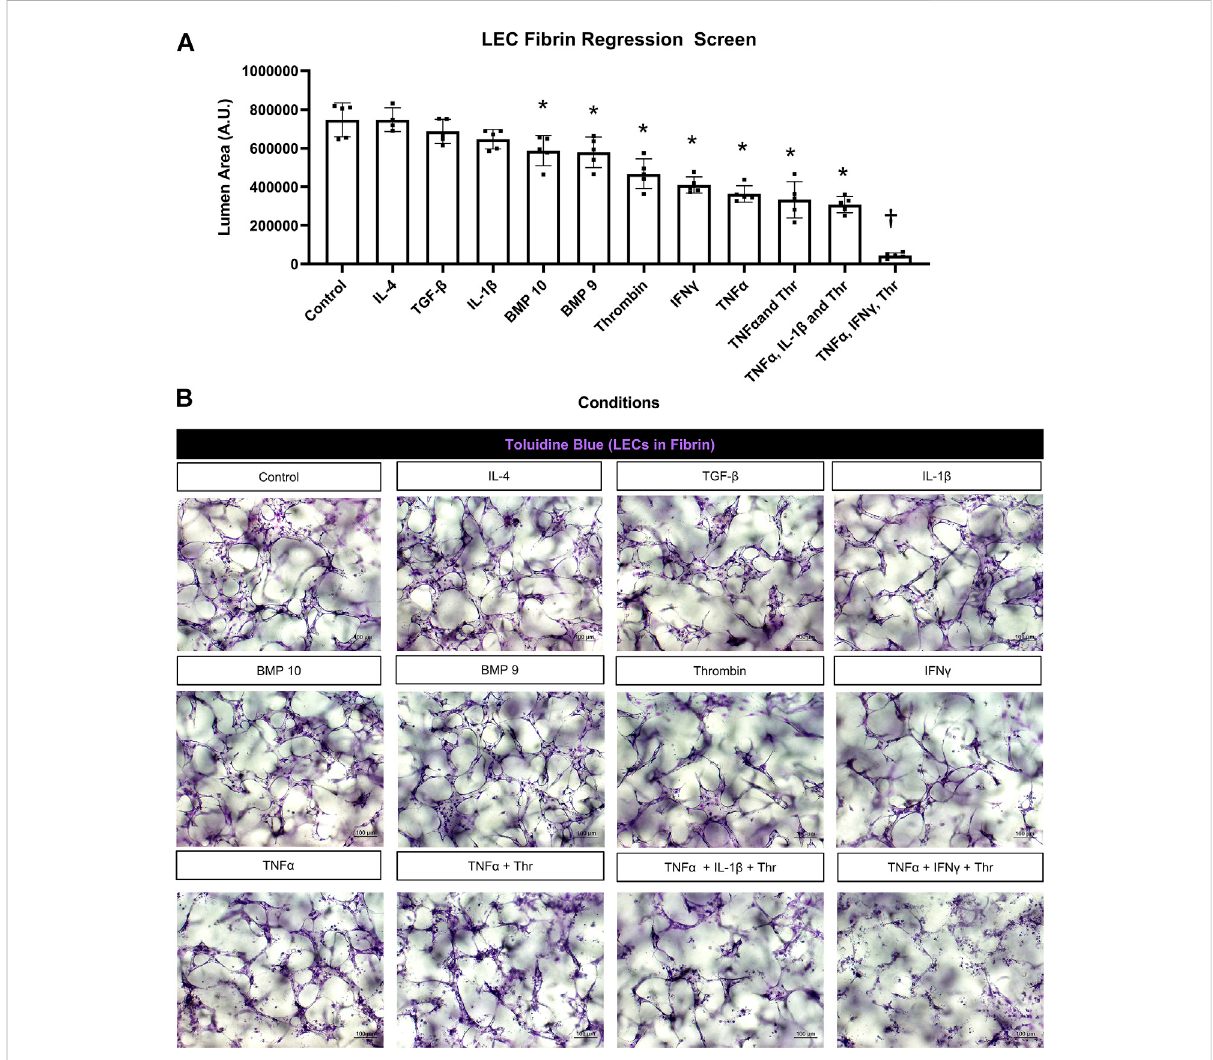
FIGURE 3 Identi fi cation of proin fl ammatory mediators that induce lymphatic EC tube regression in 3D fi brin gels. (A,B) Serum-free lymphatic endothelial cell (LEC) tube networks + FIST (10 μ M forskolin, 100 μ M IBMX, 10 μ M SB239063, and 10 μ M Tubacin) were formed for 48 h in a fi brin gel and